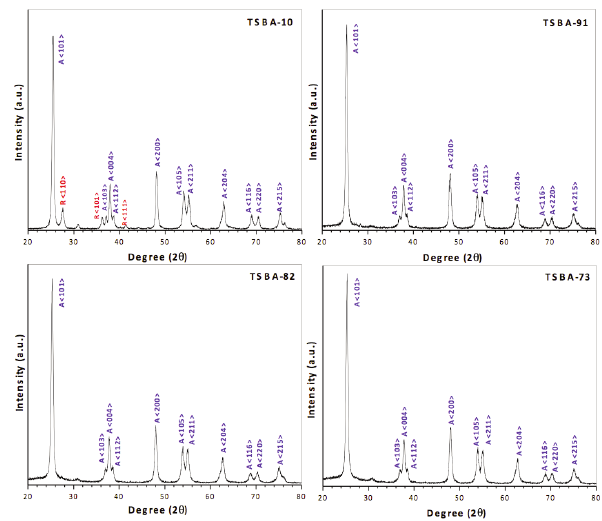
Fig. 3 - XRD spectra of the TiO 2 /SiO 2 samples with different TiO 2 /SiO 2 weight